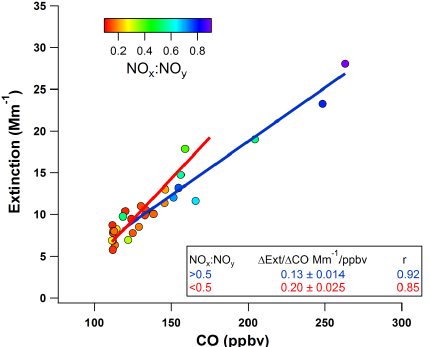
Figure 2. Orthogonal distance linear regression fits to extinction (Mm − 1 ) vs. CO (ppbv) for fresh (blue fit line) and aged air masses (red fit line).